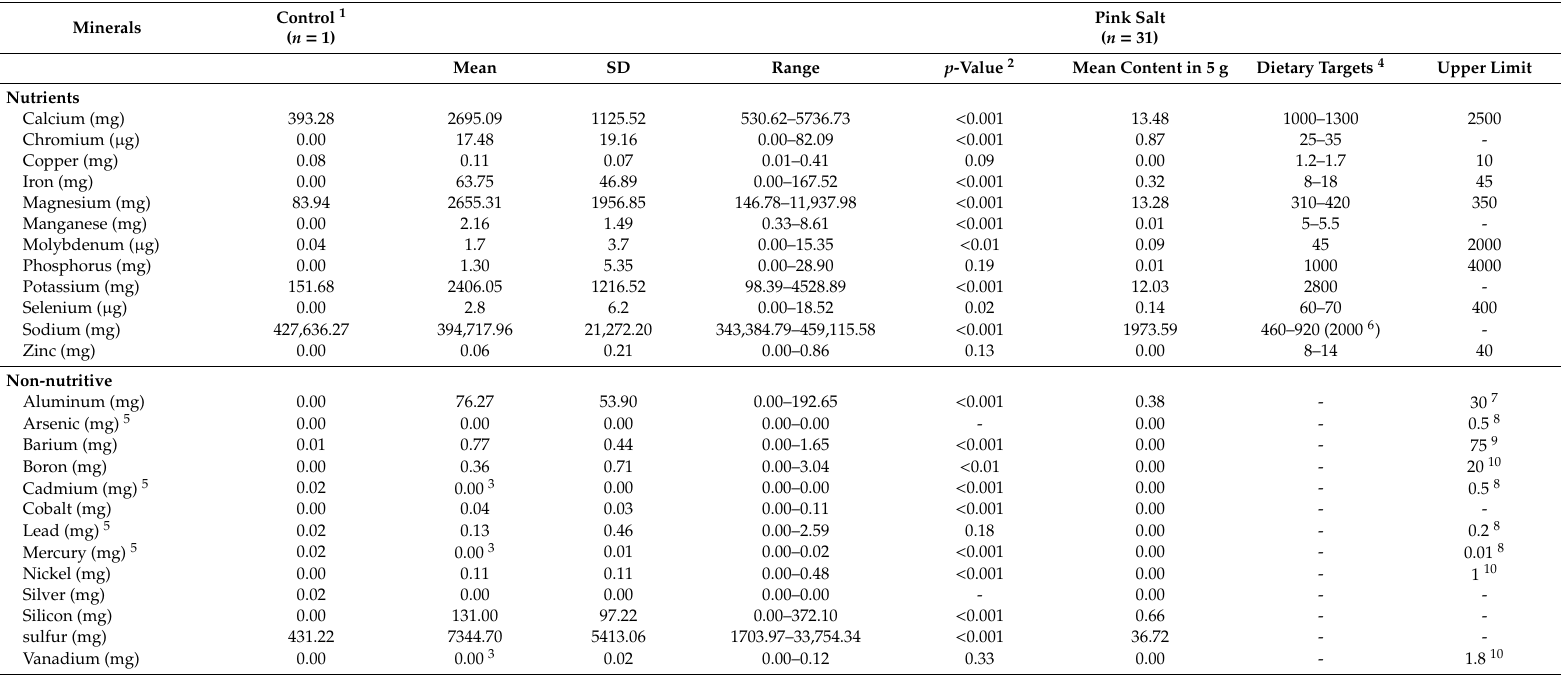
Table 4. Mean nutrient and non-nutritive mineral content per kilogram of pink salt compared to an iodized white salt control.